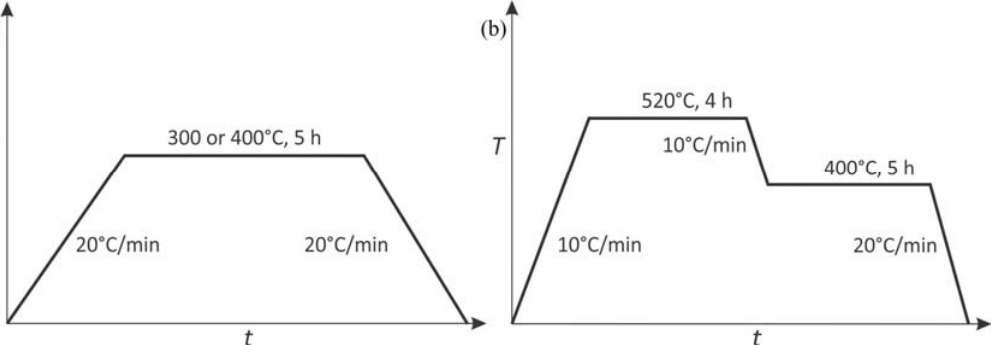
Figure 1. Time-temperature diagrams for following the processes during dilatometry tests and di ff erential scanning calorimetry: ( a ) isothermal annealing at 300 °C and 400 °C, ( b ) processes during differential scanning calorimetry: ( a ) isothermal annealing at 300 ◦ C and 400 ◦ C, ( b ) processes during homogenization and subsequent holding at 400 °C. homogenization and subsequent holding at 400 ◦